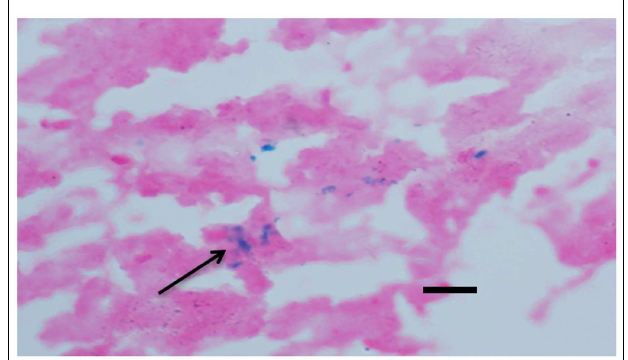
FIGURE 7 | Effects of ( − )epicatechin and curcumin consumption on microhemorrhage profiles . Microhemorrhage events in the form of the number of Prussian blue-positive profiles were counted, and the average number and standard error of hemosiderin deposits was calculated per each brain hemisphere. Comparison of microhemorrhage profiles per each brain hemisphere among groups. *, **denote P > 0.05 versus wild-type littermate fed with Control diet.